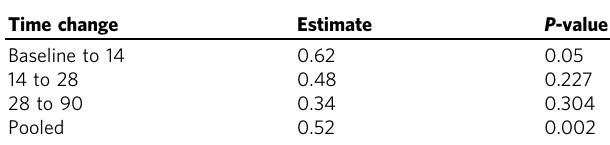
Table 4 Spearman ranked correlation between kynurenine fold-change from previous timepoint and change in depression from previous